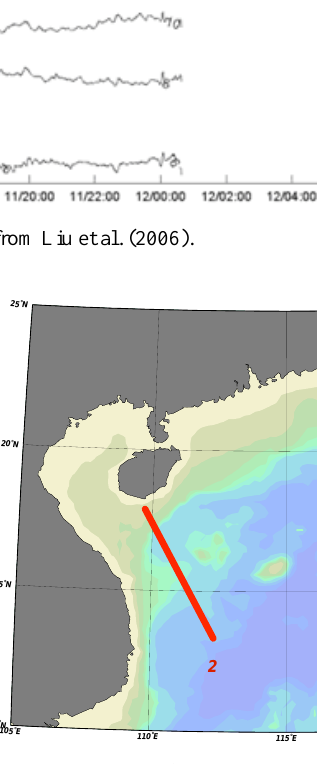
Fig. 10. Bathymetry of the South China Sea, with the chosen cross-